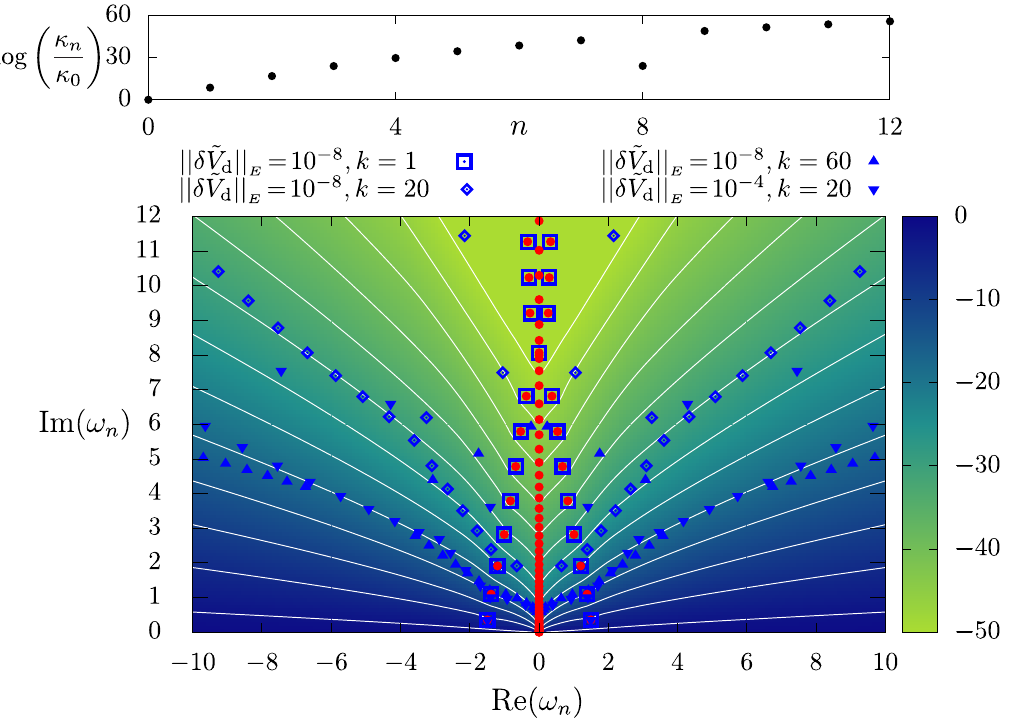
FIG. 17. Gravitational QNM spectral (in)stability in Schwarzschild spacetime (here, l ¼ 2 axial case corresponding to the Regge- Wheeler potential, same behaviour for polar modes with Zerilli potential). The figure shows the superposition of the pseudospectrum of Fig. 13, perturbed QNM spectra in Fig. 14, together with exact QNMs and condition numbers κ from Fig. 12. Employed norms follow n from the energy scalar product in Eq. (73), i.e., energy defines “ big ” and “ small ” . The pseudospectrum pattern, with ϵ -pseudospectra sets with small ϵ extending into large regions of the complex plane, indicates spectral instability of QNM overtones, consistently with the ’ s. Perturbations in the potential demonstrate the high-frequency (ultraviolet) instability of all overtones and their fastly growing κ n stability under low-frequency perturbations. Both pseudospectrum and perturbations in the potential show the ultraviolet stability of the fundamental QNM. Ultraviolet instability induce QNM overtones to migrate towards ϵ -pseudospectra contour lines, a pattern consistent with “ Nollert-Price QNM branches ” [44,45] here illustrated up to the lowest overtone. Universality of this pattern is further supported by comparison with the Pöschl-Teller potential in Fig.